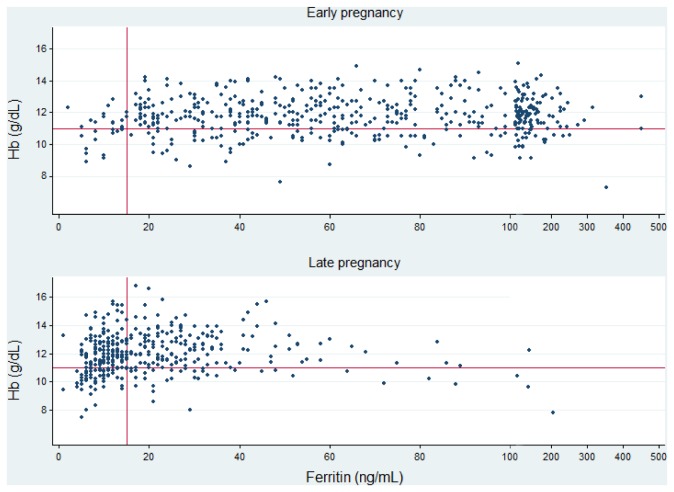
Scatter plots of ferritin and haemoglobin in early and late pregnancy in 378 women, Ha Nam province, Viet Nam in 2010.References lines for iron deficiency (ferritin < 15 ng/ml) and anaemia (Hb < 11 g/dL).